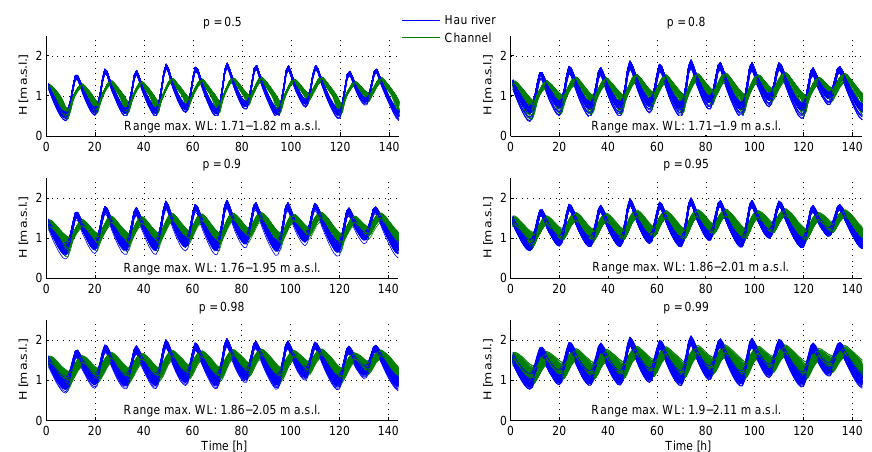
Figure 7. Boundary conditions for the fluvial hazard analysis: Hau and Can Tho Rivers (blue) and the channels entering the modelling domain from theWest (green). p denotes the annual probabilities of non-exceedance. Simulation time is six days around the maximum water level in the Hau River. For each p level 140 simulations were performed. The spread of the boundary time series denotes the variability stemming from the bivariate extreme value statistic, which increases with higher annual probabilities of non-exceedance.